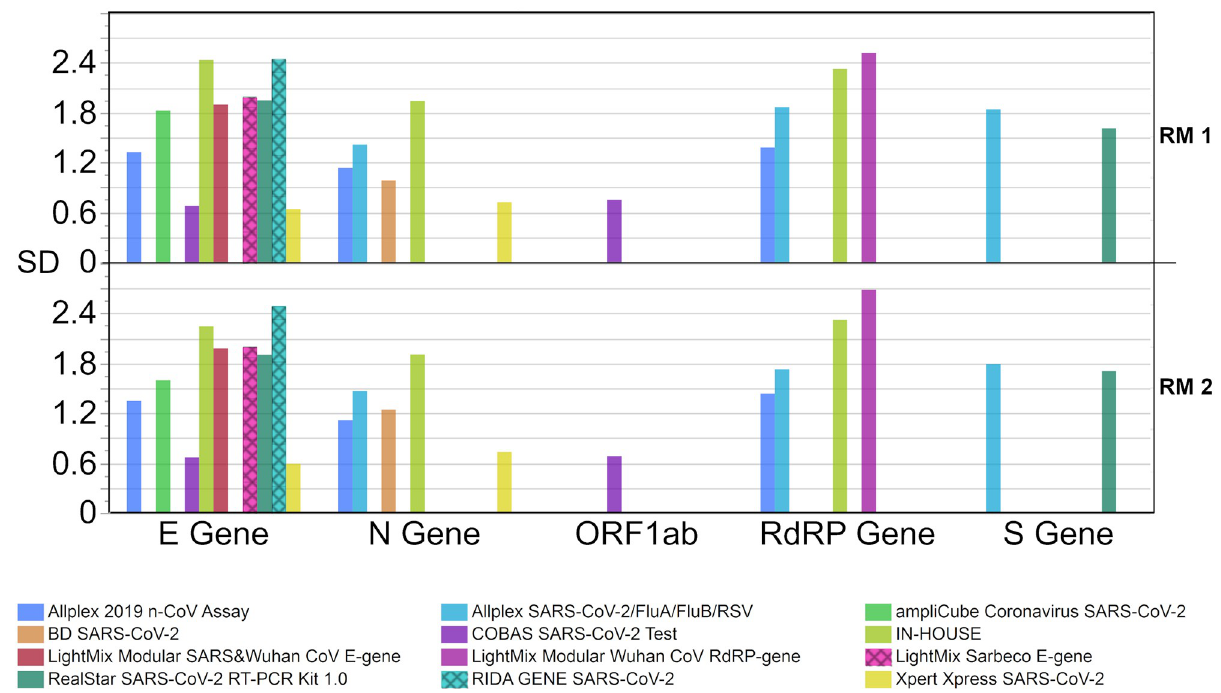
Fig 7. Standard deviation (SD) for the respective Ct value results per test system for the corresponding gene region. The concentration of RM 1 (blue) is estimated at roughly 10 7 copies/mL and the concentration of RM 2 (red) is estimated at roughly 10 6 copies/mL.